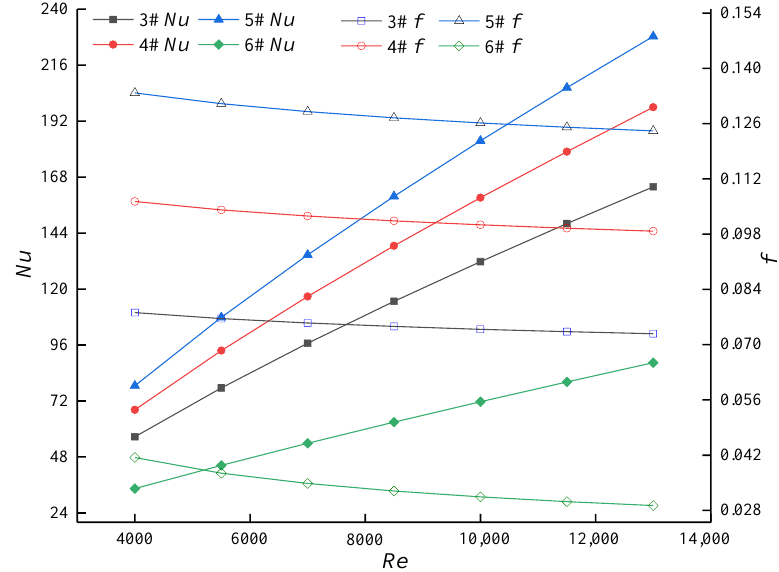
Figure 5. Effect of thread height on f and Nu .